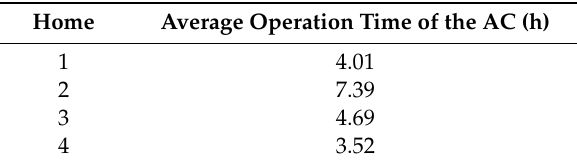
Table 8. Summary of information on AC operation.